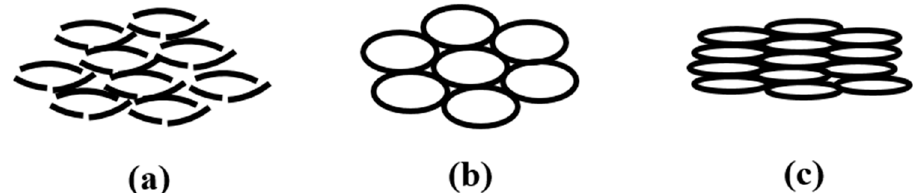
Figure 10. Different compression conditions of straw core material: collapse ( a ), intact ( b ), and deformation ( c ).